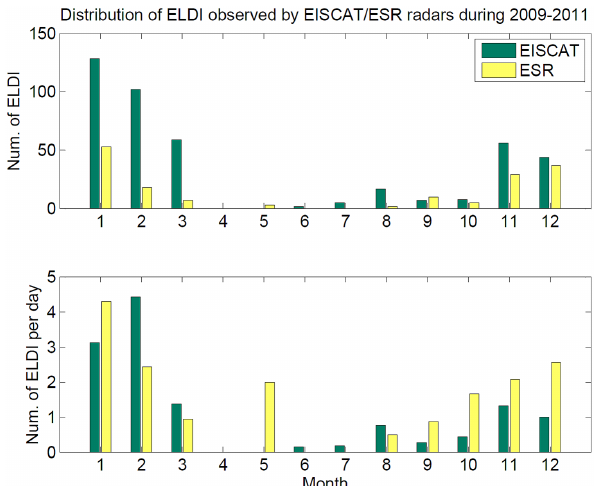
Figure 3. Distribution of ELDI observed by EISCAT/ESR radars during 2009–2011. The top panel denotes for absolute number of ELDI detected by radars and the bottom panel for normalized num- ber of ELDIs with observations in Fig. 1b.